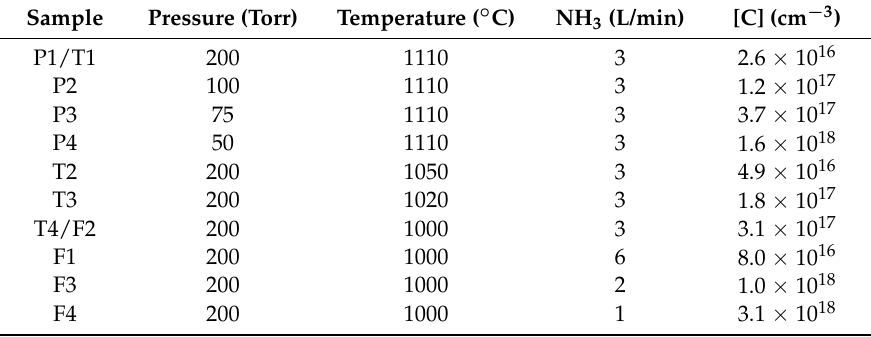
Table 1. Growth conditions of u-GaN samples. [C]: concentration of carbon impurity.